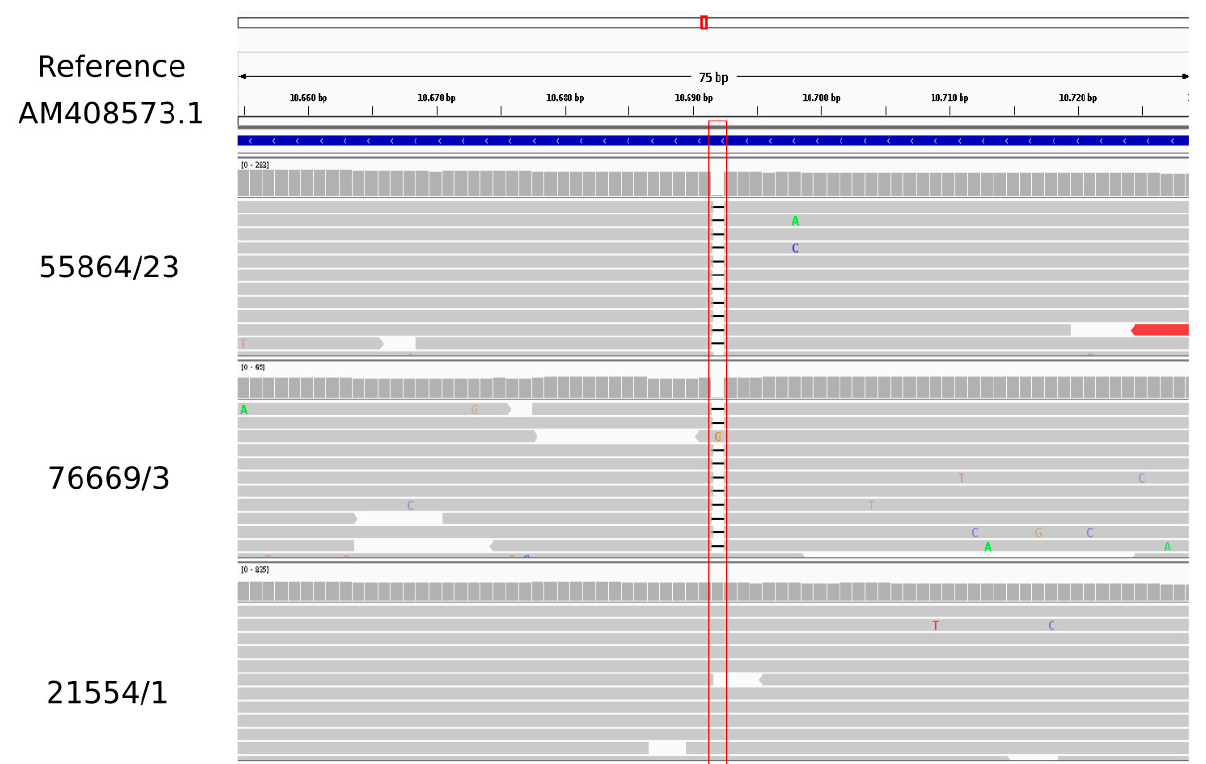
Figure 1. Visualisation of the variant calling analysis obtained for cfr gene of the three LA-MRSA isolates using as reference the Tn558 transposon of plasmid pSCFS6 ( S. warneri (AM408573) (CGE database)).